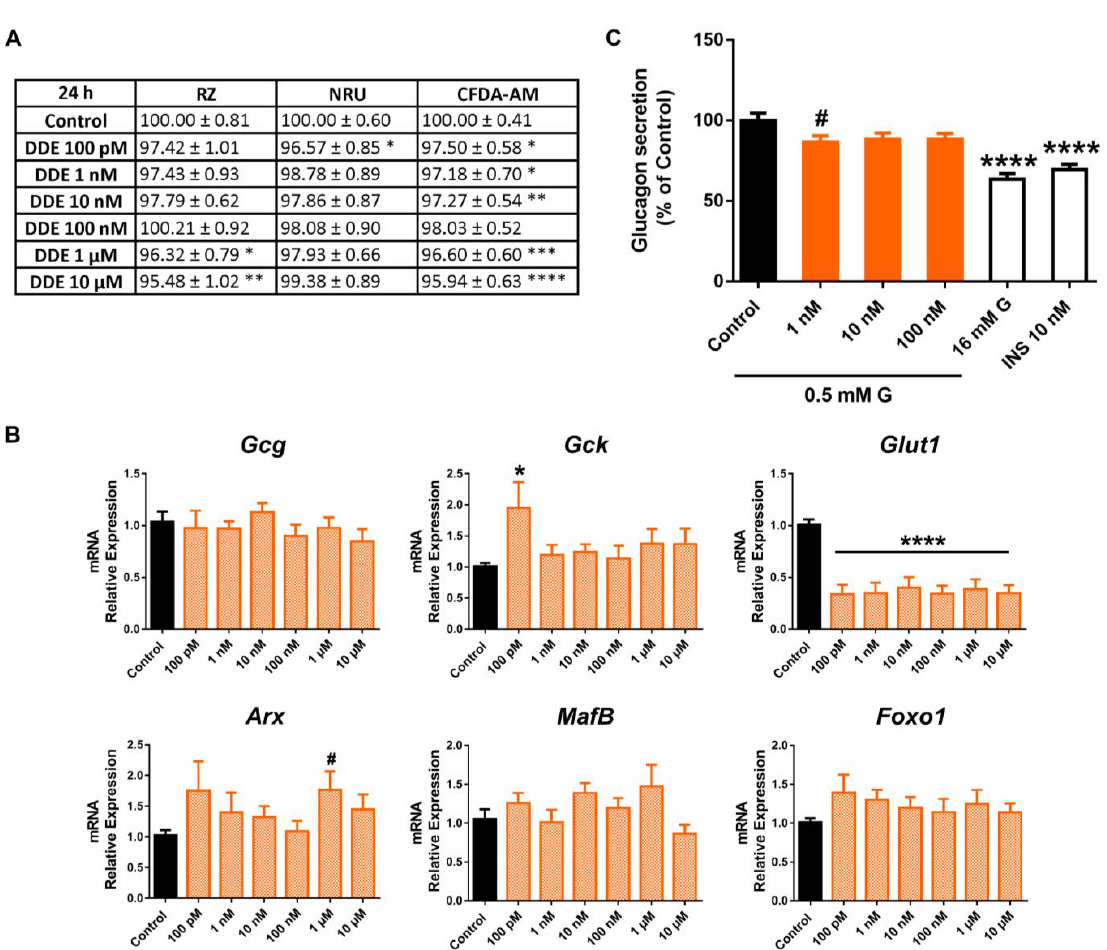
Figure 9. DDE effects on pancreatic α -cells. ( A ) Viability of pancreatic α TC1-9 cells treated for 24 h with different concentrations of DDE (100 pM–10 µ M) as evaluated by RZ, NRU, and CFDA-AM assays. Results are expressed as % of the solvent controls (Control = 100%). ( B ) mRNA expression of Gcg , Gck , Glut1 , Arx , MafB , and Foxo1 in control- and DDE-treated α TC1-9 cells for 24 h. ( C ) Glucagon secretion in α TC1-9 cells treated for 24 h with DDE. Data are represented as mean ± SEM of ( A ) n = 5, ( B ) n = 3, ( C ) n = 6 independent experiments. * vs. Control; * p < 0.05, ** p < 0.01, *** p < 0.001, **** p < 0.0001 by one-way ANOVA followed by Dunnett ’ s post hoc test or Kruskal – Wallis followed by Dunn’s post hoc test . # vs. Control; # p < 0.05 by the Student’s t test. At the gene-expression level, we found a dramatic reduction in Glut1 mRNA levels, which was significant at all doses assayed from 100 pM to 10 μ M (Figure 9B). In addition, some minor changes were quantified, including the enhanced expression of Gck and Arx at the 100 pM and 1 μ M doses, respectively (Figure 9B). Finally, a slight decrease in glu- cagon secretion was found, although the inhibitory effect was only significant at the 1 nM concentration (Figure 9C).